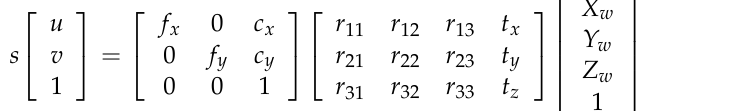
Figure 5. Range sensors’ touch points centralization with their corresponding color pads.